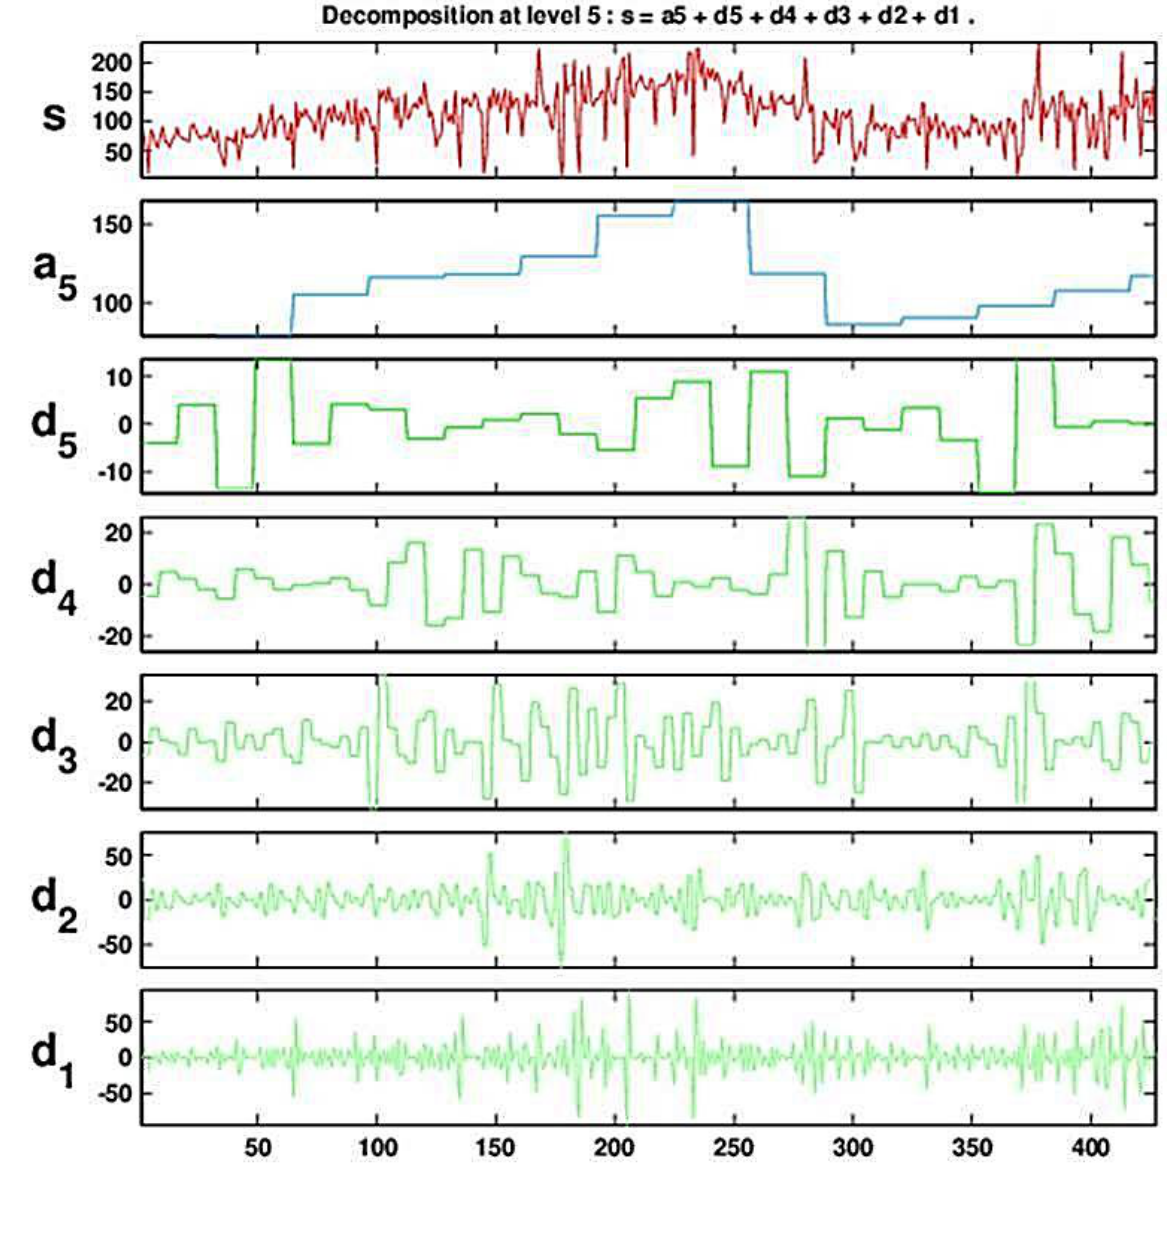
Figure 4. Decomposing the series of daily visits to military outpatient clinics into five levels using the Haar wavelet. The top panel displays the time-series. Below it is the multiresolution analysis that includes the fifth approximation and the five levels of